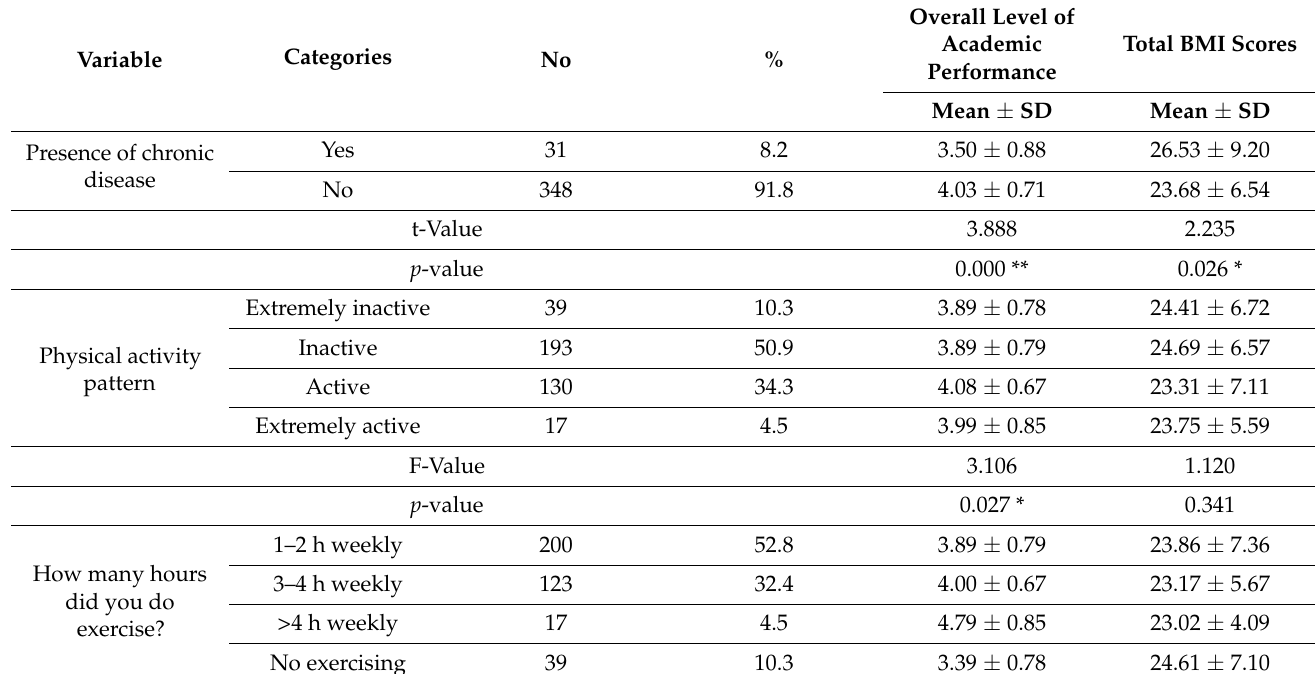
Table 6. Mean and significant differences among total BMI scores, overall academic performance level, clinical and physical data, and non-physical activity pattern of the studied participants (n =